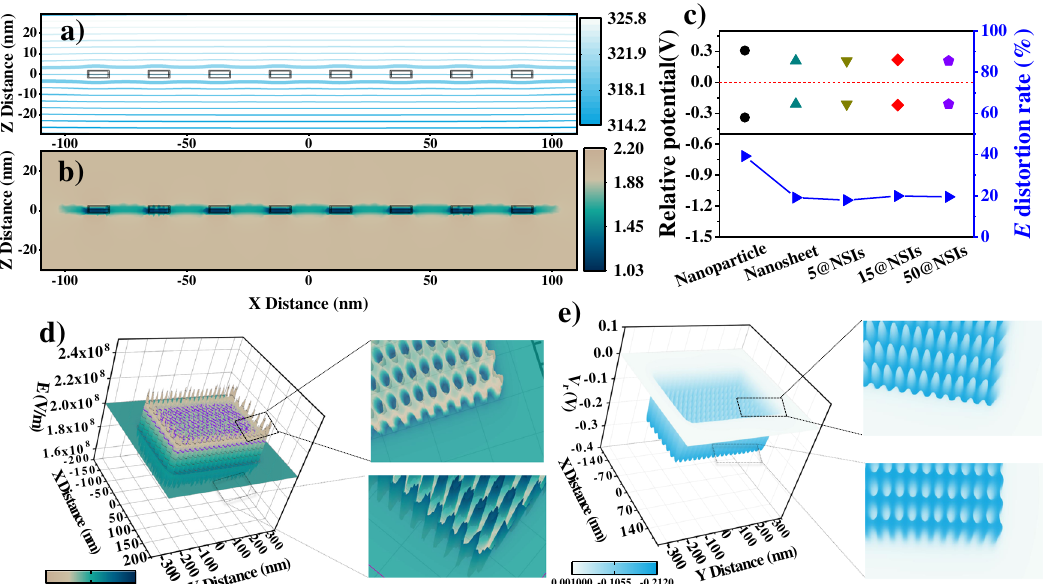
Fig. 4 | Steady-state E and V distribution. a Equipotential lines around the nano- sieveinP(VDF-HFP)dielectric. b Localelectric fi eld distortion(verticaldirection)near a nano-sieve/polymer matrix interface under an external E=200MV/m. c Relative potential difference (V r ) and electric fi eld distortion rate ( ξ ) induced by, nanosheet, 5@NSIs, 15@NSIs, and 50@NSIs. (V r =V min (cid:1) V theory , ξ = ðð E max (cid:1) E ex Þ = E ex Þ ×100%; where V min is minimum of V in the selected area, V theory is the theoretical potential without nanomaterials at the site, E max is maximum of E in the selected area, E ex is